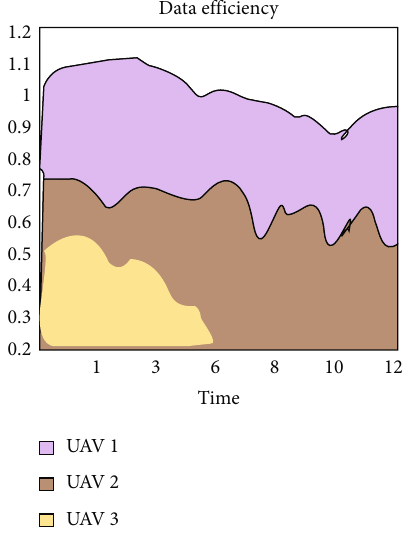
Figure 10: Fluctuation range of data processing and calculation in UAV